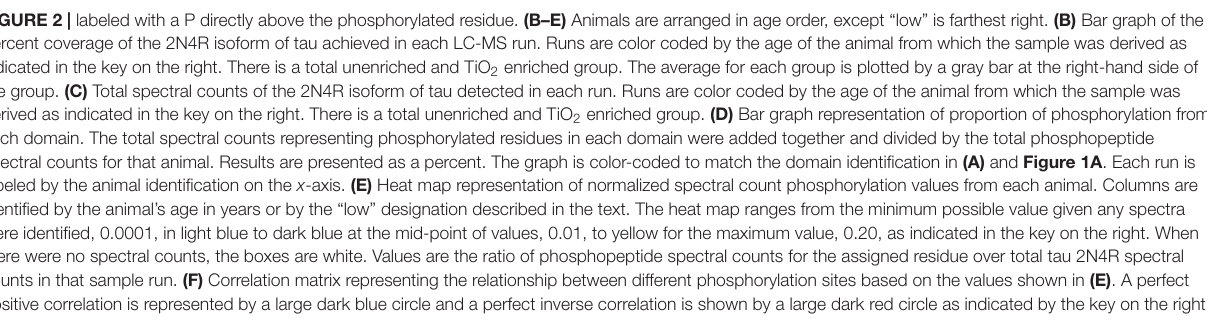
FIGURE 2 | labeled with a P directly above the phosphorylated residue. (B–E) Animals are arranged in age order, except “low” is farthest right. (B) Bar graph of the percent coverage of the 2N4R isoform of tau achieved in each LC-MS run. Runs are color coded by the age of the animal from which the sample was derived as indicated in the key on the right. There is a total unenriched and TiO 2 enriched group. The average for each group is plotted by a gray bar at the right-hand side of the group. (C) Total spectral counts of the 2N4R isoform of tau detected in each run. Runs are color coded by the age of the animal from which the sample was derived as indicated in the key on the right. There is a total unenriched and TiO 2 enriched group. (D) Bar graph representation of proportion of phosphorylation from each domain. The total spectral counts representing phosphorylated residues in each domain were added together and divided by the total phosphopeptide spectral counts for that animal. Results are presented as a percent. The graph is color-coded to match the domain identification in (A) and Figure 1A . Each run is labeled by the animal identification on the x -axis. (E) Heat map representation of normalized spectral count phosphorylation values from each animal. Columns are identified by the animal’s age in years or by the “low” designation described in the text. The heat map ranges from the minimum possible value given any spectra were identified, 0.0001, in light blue to dark blue at the mid-point of values, 0.01, to yellow for the maximum value, 0.20, as indicated in the key on the right. When there were no spectral counts, the boxes are white. Values are the ratio of phosphopeptide spectral counts for the assigned residue over total tau 2N4R spectral counts in that sample run. (F) Correlation matrix representing the relationship between different phosphorylation sites based on the values shown in (E) . A perfect positive correlation is represented by a large dark blue circle and a perfect inverse correlation is shown by a large dark red circle as indicated by the key on the